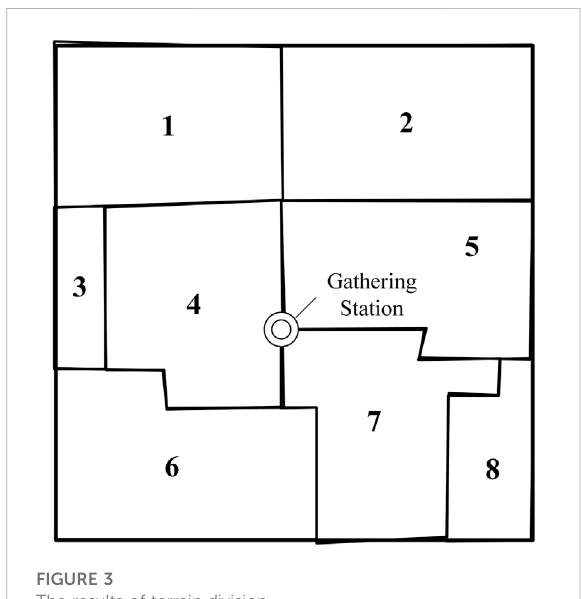
FIGURE 3 The results of terrain